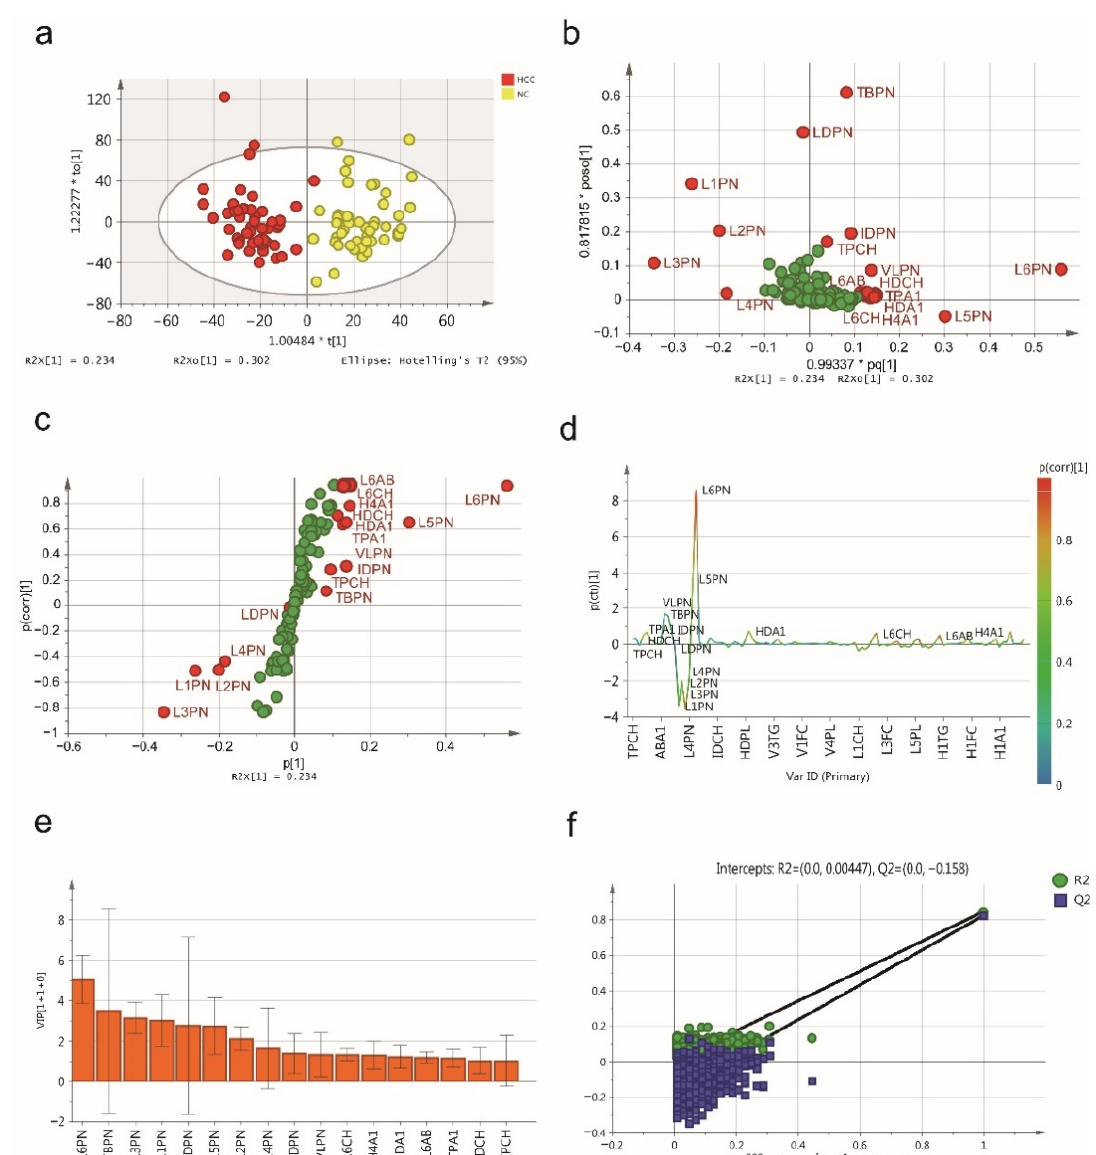
(Figure 1f) was performed, and the results (intercepts: R 2 = 0.138, Q 2 = − 0.313) indicated that this OPLS-DA model had high discriminability.